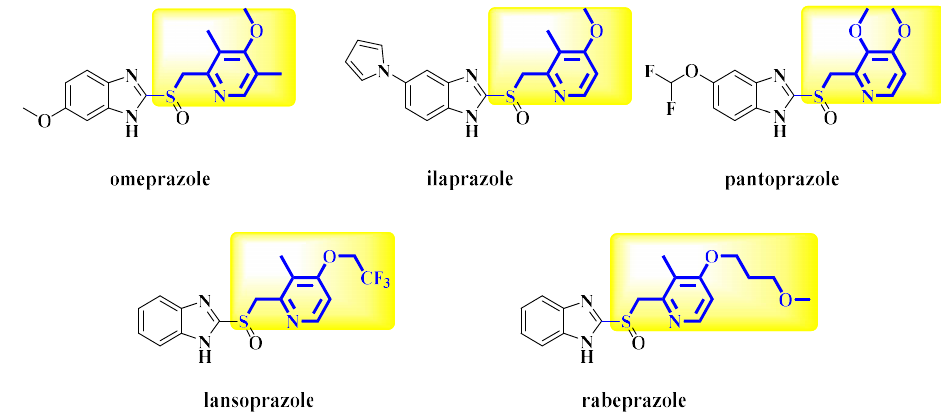
Figure 1. Chemical structures of proton pump inhibitors (PPIs).